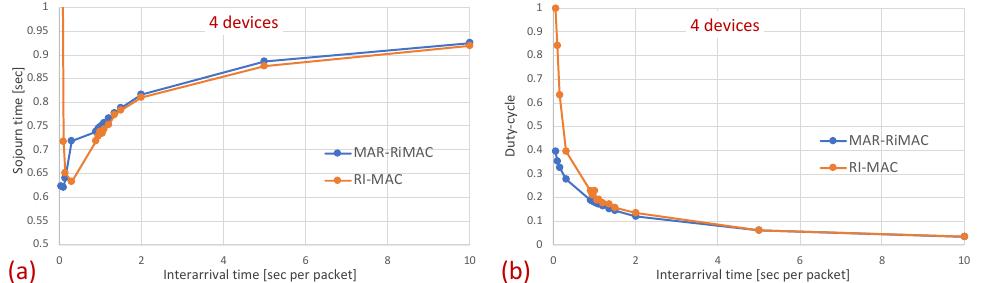
Figure 18. Hidden-terminal topology: The performance attained by a four-device topology under very heavy to light traffic loads. ( a ) Sojourn time. ( b ) Duty